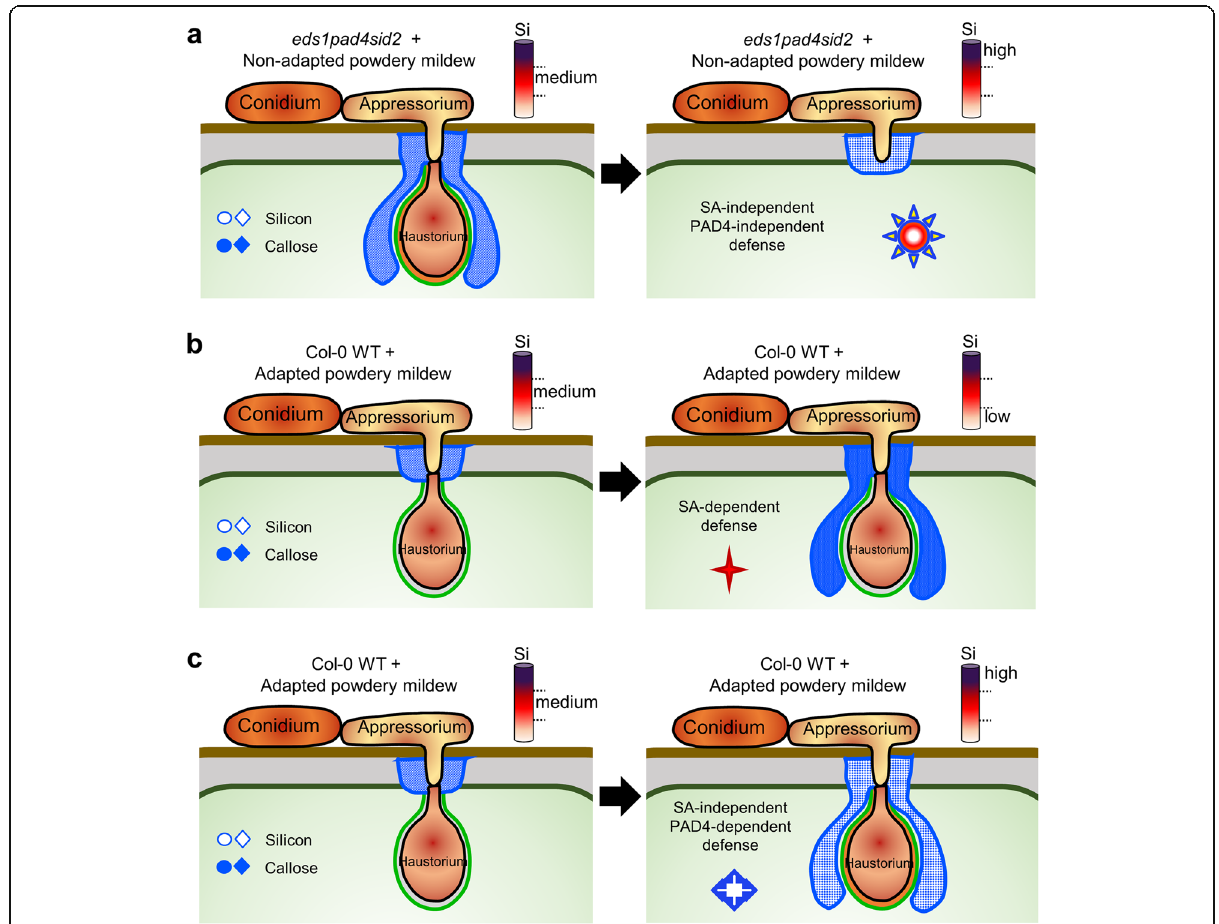
Fig. 7 Schematic diagram describing the three scenarios where very low Si or high Si confers enhanced resistance to powdery mildew, and the potential synergistic action between Si and callose. Based on publish results and our observations from this study, we speculate that Si may polymerize with cell wall components especially callose to fortify the cell wall as a major preformed physical barrier to defend plant cells against cell wall-penetrating non- and poorly-adapted pests such as powdery mildew. Compromised resistance against such pathogens due to loss of EDS1, PAD4 and SID2 can be compensated by more Si deposition ( a ). Adapted powdery mildew has largely overcome this physical barrier; however, depriving Si or callose from such structures may generate a warning signal to activate SA-dependent defense that can promote the callose-rich papilla to further “ grow ” to (half) encase the haustorium (Meyer et al. 2009), limiting the growth of the adapted powdery mildew ( b ). High Si can strengthen the papilla and the callosic encasement, which requires a PAD4-dependent (but SA-independent) mechanism, resulting in enhanced basal resistance ( c